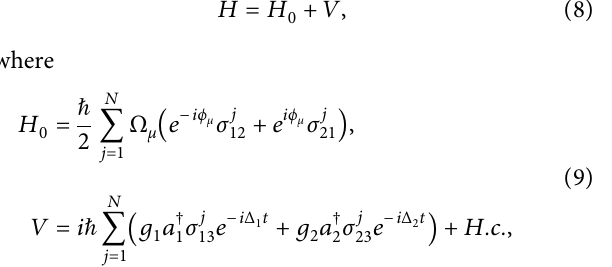
figure is the cooperation parameter C � 200: the solid line � 0 . 02; the yellow dotted line corresponds corresponds to c 1 � 0 . 03; and the green dotted line corresponds to to c 1 c � 0 . 05. The graph in the figure is the variation curve of the 1 〉 � 〈 I 〉 of each mode with the incoherent intensity 〈 I 1 2 hundred-pull rate in units of c 2 / g 2 , and the value of the 2 parameter is the same as that of the zero-frequency output spectrum. It can be seen from the figure that the